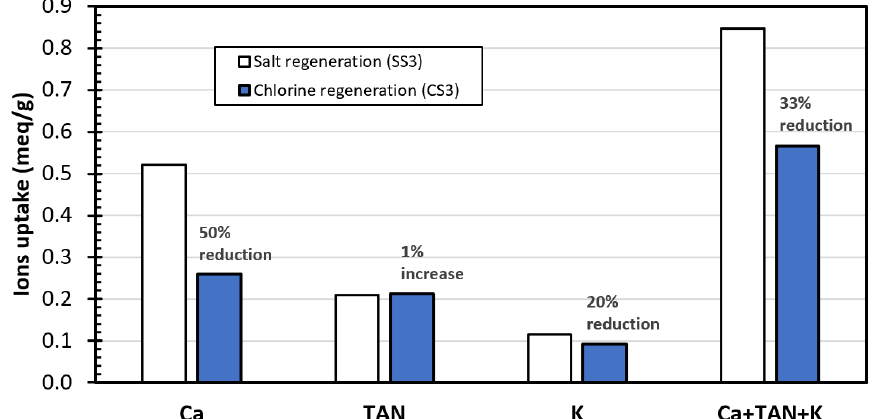
Figure 8. Cumulative ion uptakes at the end of the 6 h loading cycles with NaCl and NaOCl regeneration.